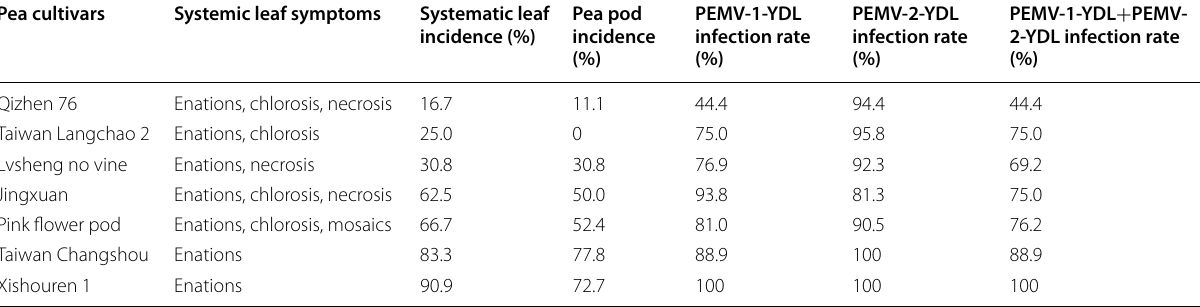
PEMV-2-YDL on different pea cultivars +